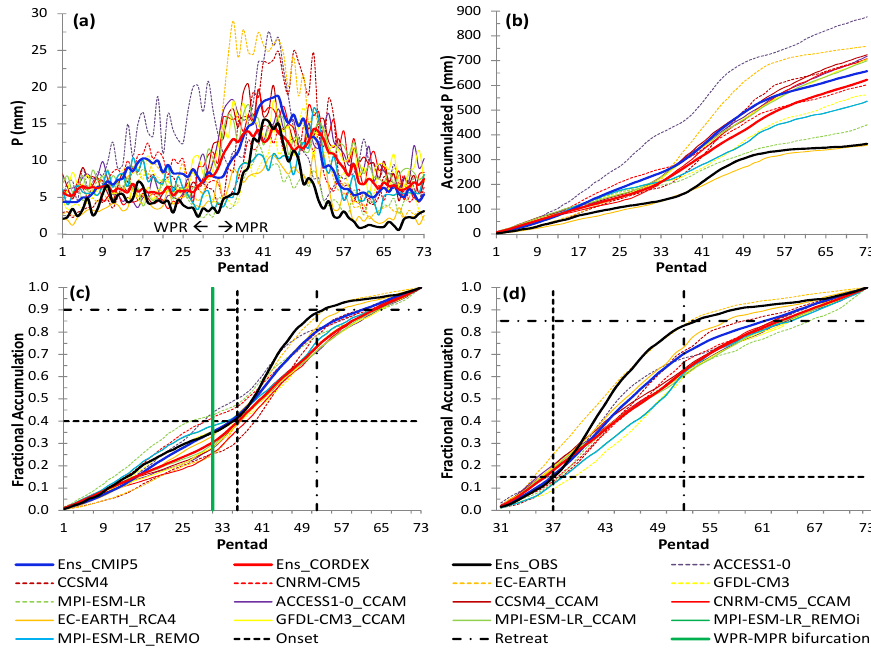
Figure 2. The inter-model spread of the basin-integrated pentad precipitation for Indus basin from CORDEX South Asia and their driving CMIP5 experiments and ensemble means in: ( a ) climatological annual cycle (mm); ( b ) accumulated precipitation (mm); ( c ) fractional accumulated precipitation; ( d ) fractional accumulation excluding January to May period of